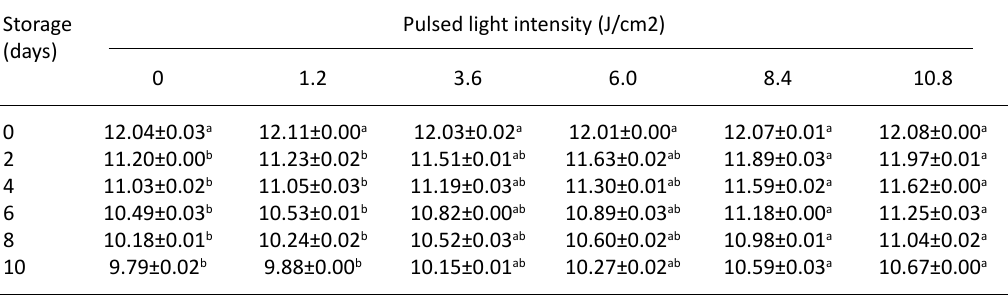
table 5. Dry matter (Brix) of Chinese kale affected by pulsed light intensity (J/cm 2 ) Storage Pulsed light intensity